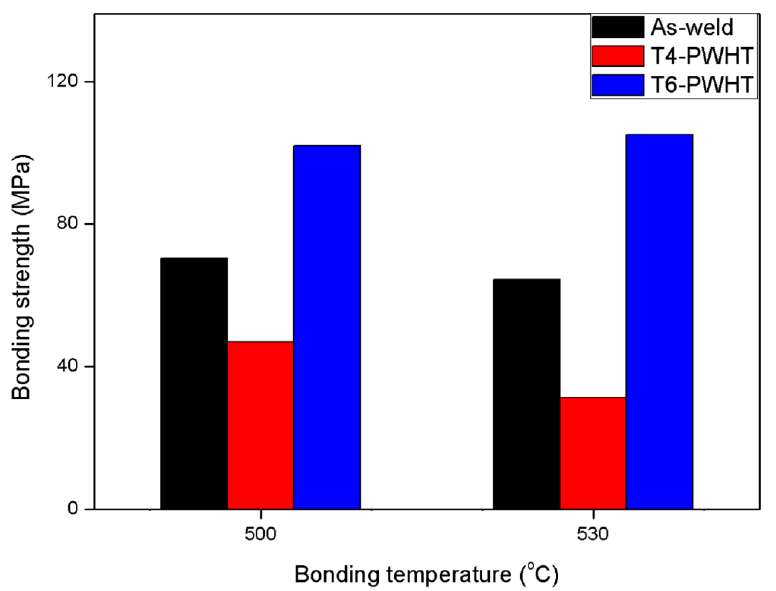
Figure 9. Bonding strengths of AA6061 joints diffusion bonded at 500–530 °C for 30–240 min after T4- and T6-PWHT.